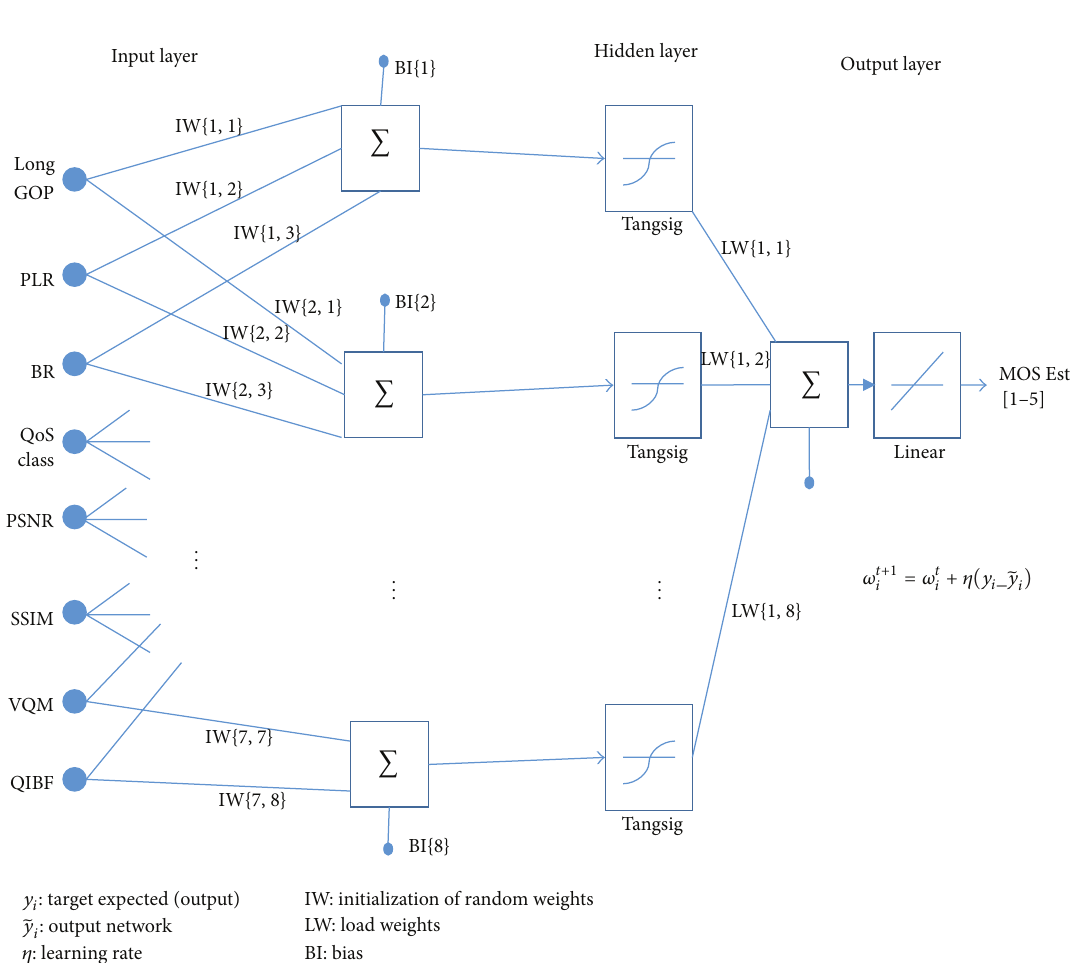
Figure 5: Proposed architecture for estimating MOS through BPNN